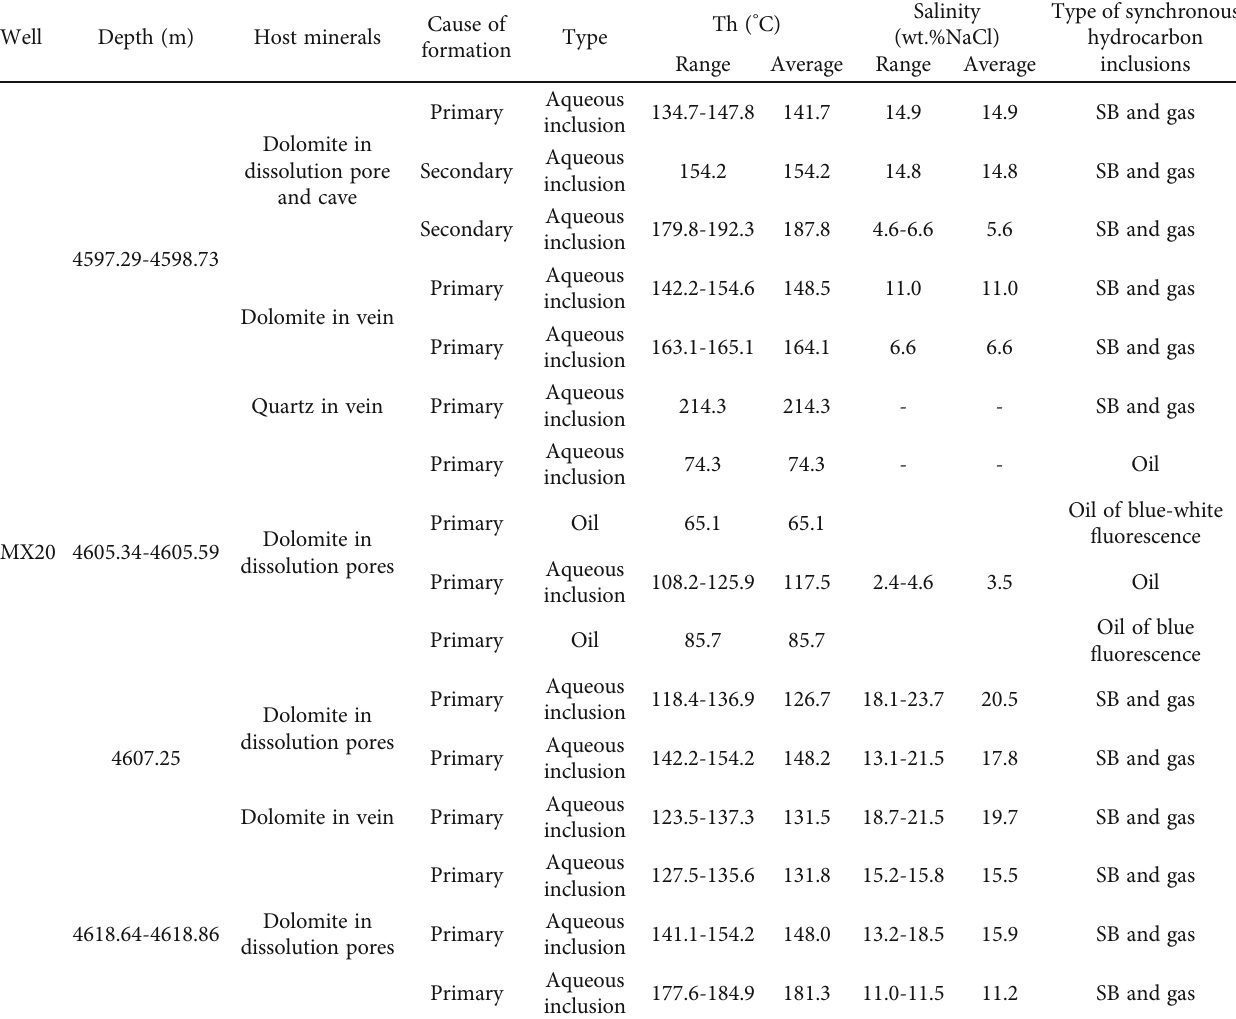
Table 2: Measured Th and salinities (S) of fl uid inclusions in the Longwangmiao Formation, Well MX20. Well Depth